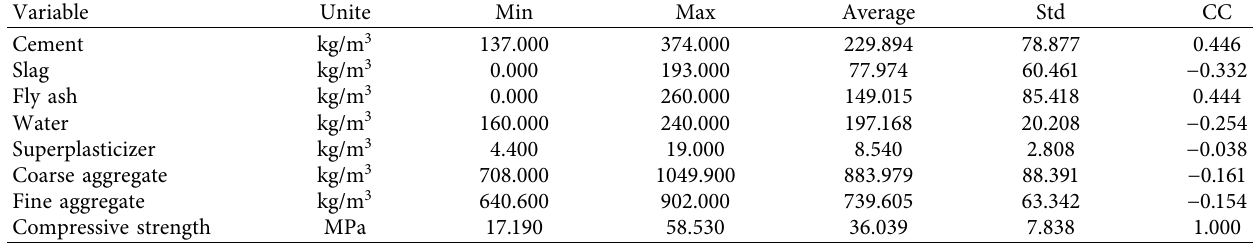
Table 1: The statistical description of the used variables in this